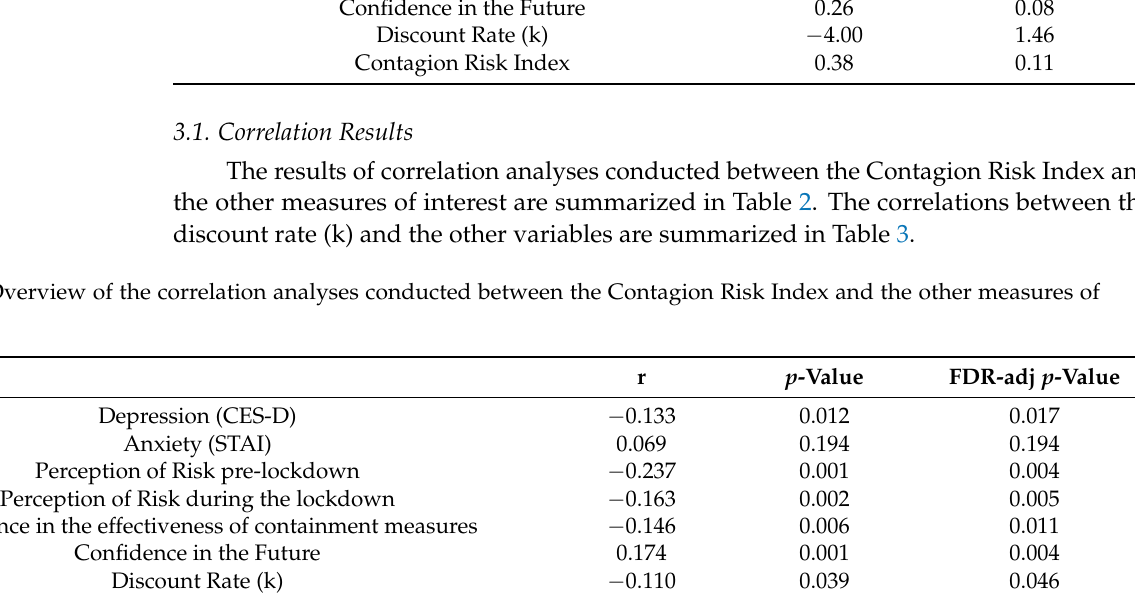
Table 3. Overview of the correlation analyses conducted between the discount rates (k) and the other measures of interest.